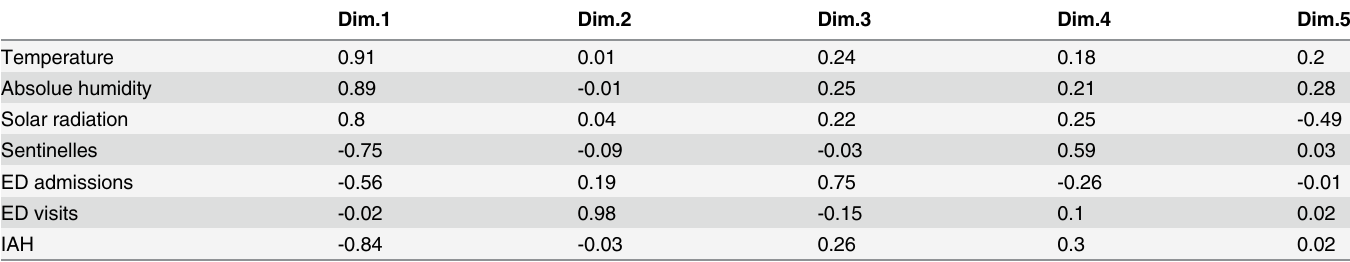
Table 4. PCA — Contribution of variables in PCA first five dimensions. Dim.1 Dim.2 Dim.3 Dim.4